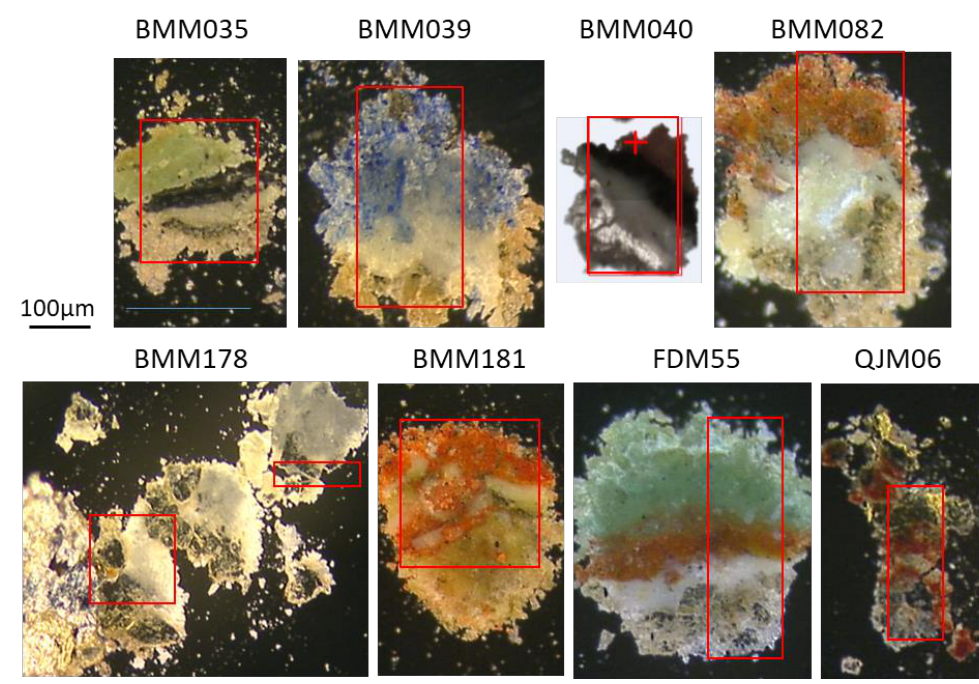
Figure 5. Optical microscopic pictures of some samples (fragments pressed between diamond cells). The red rectangles represent the regions analyzed with SR-µFTIR (cf. Figure 6). Table 3. Summary of the identification of the main organic components in Bamiyan’s paintings, using SR µFTIR mapping. The location of the components is given when the sample structure was sufficiently well preserved. * Indicates samples that have been analyzed only as thin resin-embed- ded sections. x indicates that the component has been detected but not assigned to a specific layer.